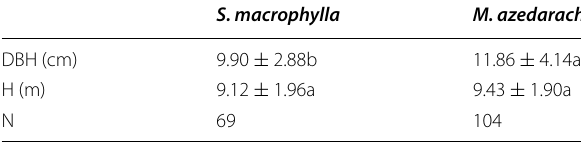
Means followed by different lowercase letters differ significantly between seasons at P <